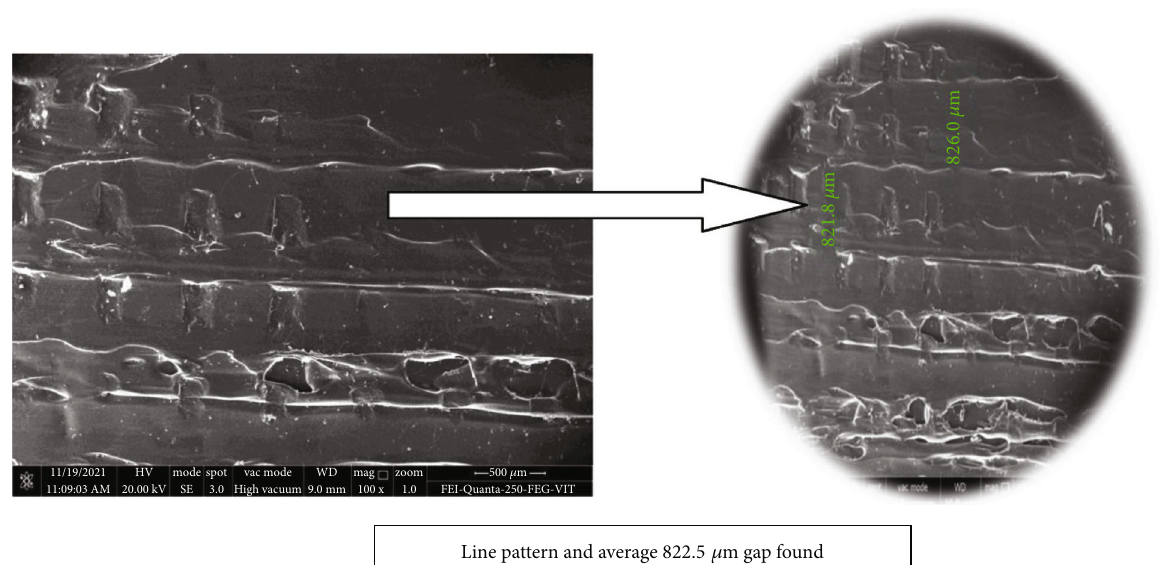
Figure 6: Line pattern